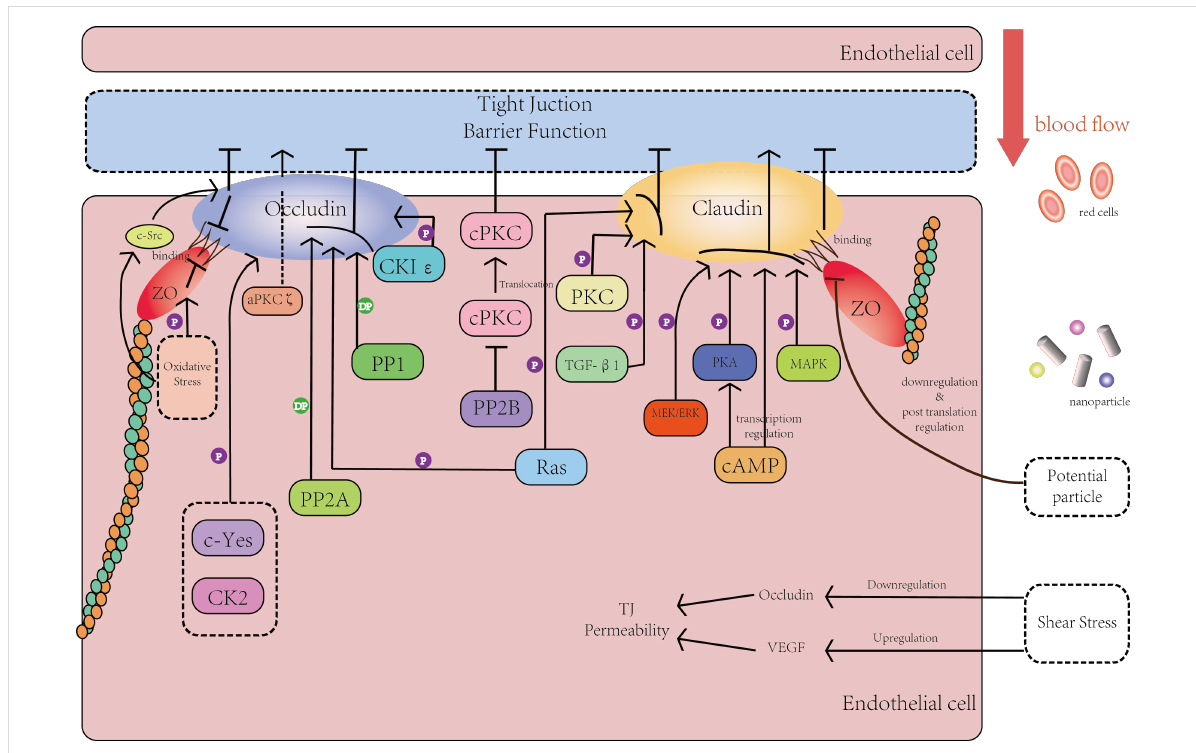
Figure 1: The effects of the phosphorylation process and other processes on the tight junction and its core proteins. For more details see main text.